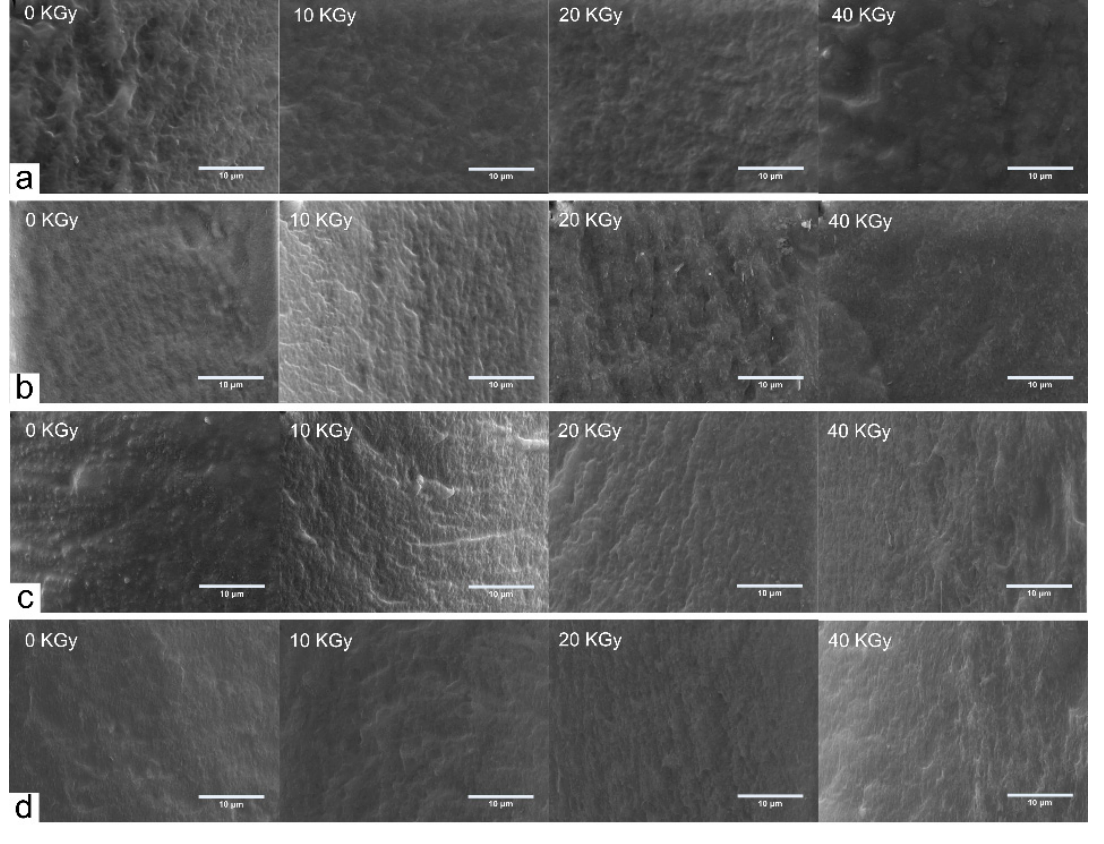
Figure 5. Scanning electron microscopy (SEM) images of CS/GO composite films with different content of GO: ( a ) 0 wt %; ( b ) 1 wt %; ( c ) 3 wt %; ( d ) 5 wt % under the various irradiation doses.